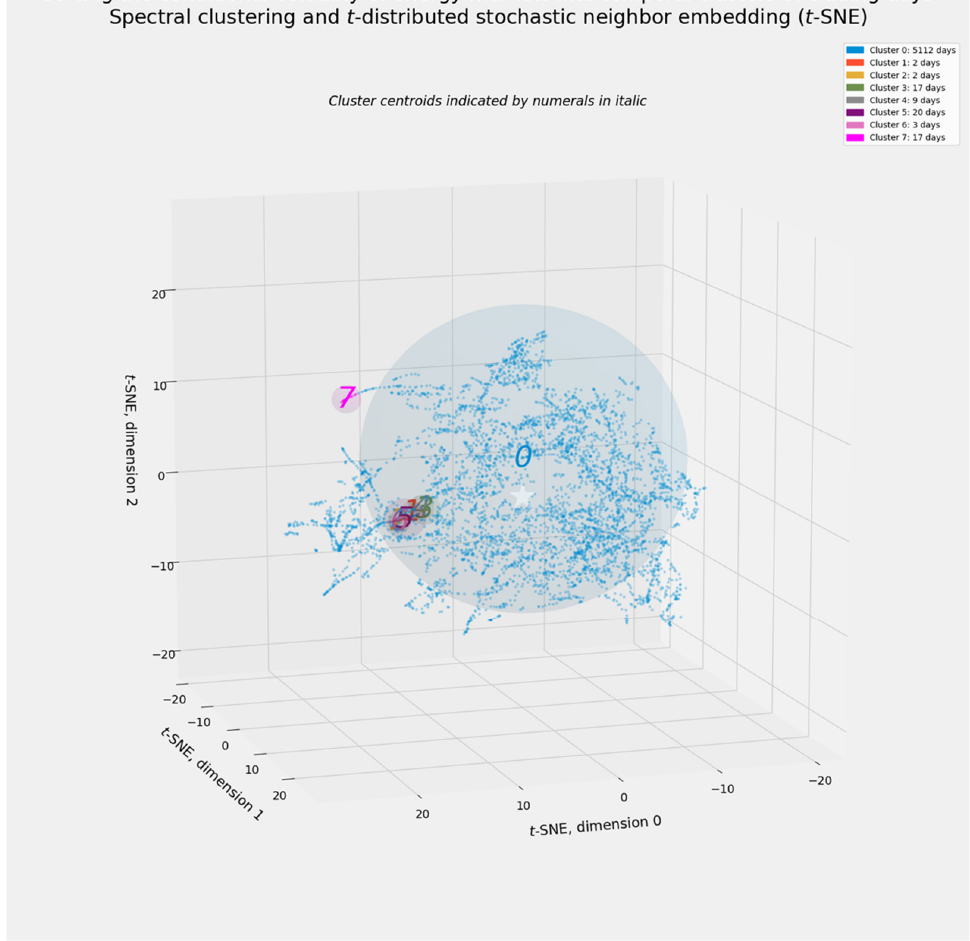
Figure 18. Spectral clustering of energy-related markets—A t -SNE manifold. On the energy-specific subarray, as with the full array, spectral clustering is a very conservative method. It finds fewer and smaller clusters apart from a single large cluster of ordinary observations. In Figure 18, clusters 1 through 6 adhere together during the COVID-19 pandemic. Cluster 7 stands apart in time and contains 17 consecutive trading days. Cluster 0 accounts for nearly 99 percent of the full 5182 days.